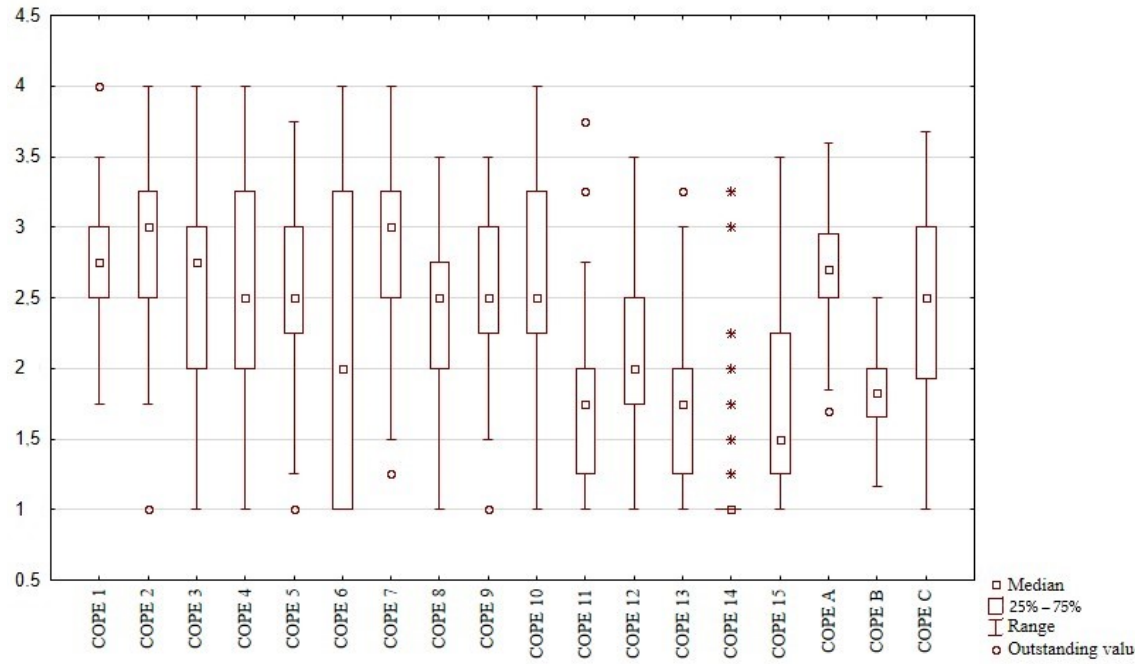
Figure 1. Frequency of coping strategies used in the study group according to COPE results. COPE 1—active coping,